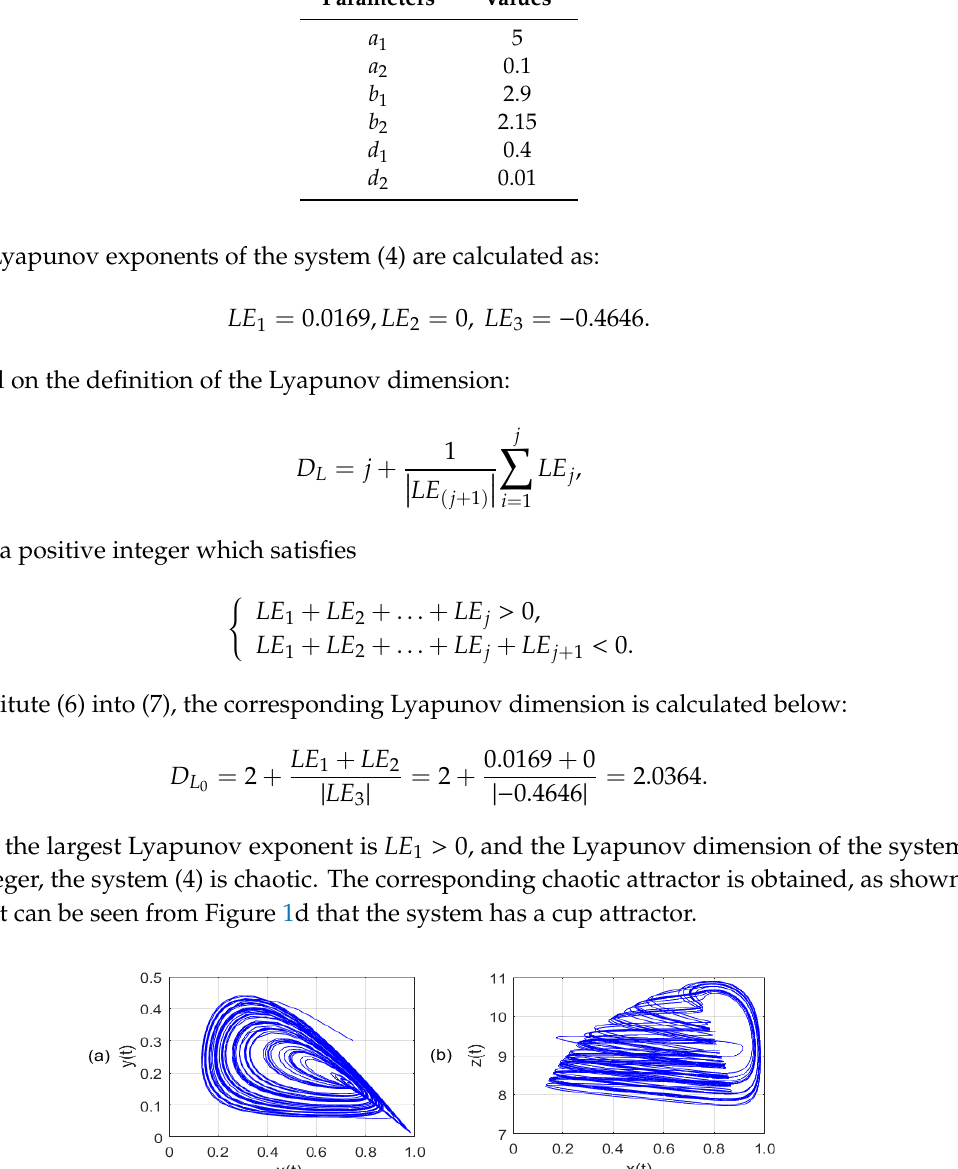
Table 1. The values of the parameters a 1 , a 2 , b 1 , b 2 , d 1 , d 2 . Parameters